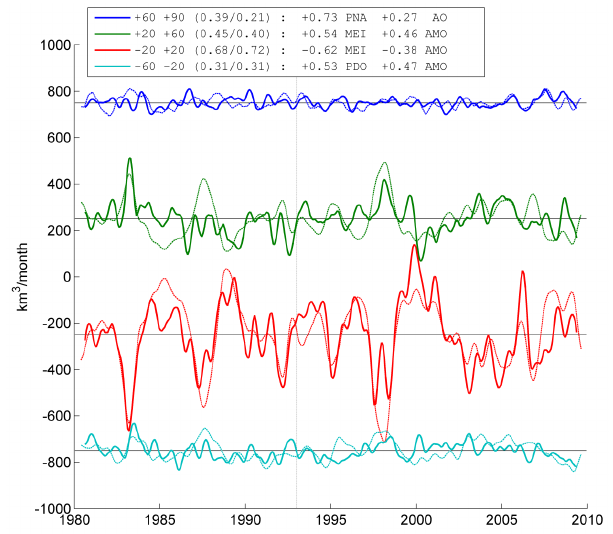
Fig. 9. Comparison of zonal runoff computed from land– atmosphere–water budgets ( R l , solid lines) and combined runoff in- Figure 9: Comparison of zonal runoff computed from land-atmosphere water budgets (R l , 3 solid lines) and Combined Runoff Index (CRI, dashed lines) over northern high latitudes 4 dex (CRI, dashed lines) over northern high latitudes (60 ◦ N–90 ◦ N), (60°N-90°N), northern mid latitudes (20°N-60°N), intertropical zone (20°S-20°N) and 5 northern mid-latitudes (20 ◦ N–60 ◦ N), intertropical zone (20 ◦ S– southern mid latitudes (60°S-20°S). For each zone, time series are shifted vertically for 6 20 ◦ N) and southern mid-latitudes (60 ◦ S–20 ◦ S). For each zone, clarity. CRI has been normalized to match the range of global runoff variability. The two 7 numbers in the brackets represent the correlation between R l and CRI for the calibration 8 time series are shifted vertically for clarity. CRI has been normal- period (1993-2009) and the whole period, respectively. Results of calibration (climate indices 9 ized to match the range of global runoff variability. The two num- and related coefficients) are given in the legend box. 10 bers in the brackets represent the correlation between R l and CRI 11 for the calibration period (1993–2009) and the whole period, re- spectively. Results of calibration (climate indices and related coef- ficients) are given in the legend